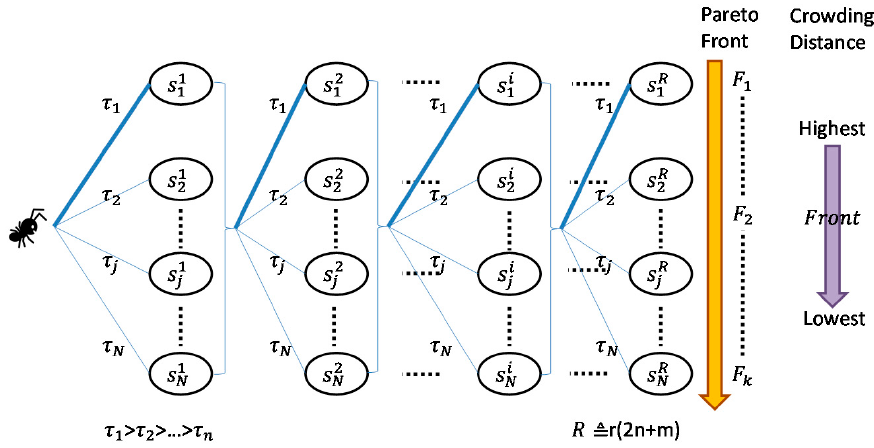
Figure 3. Illustration of the elite selection, where the bold line denotes a selected path.